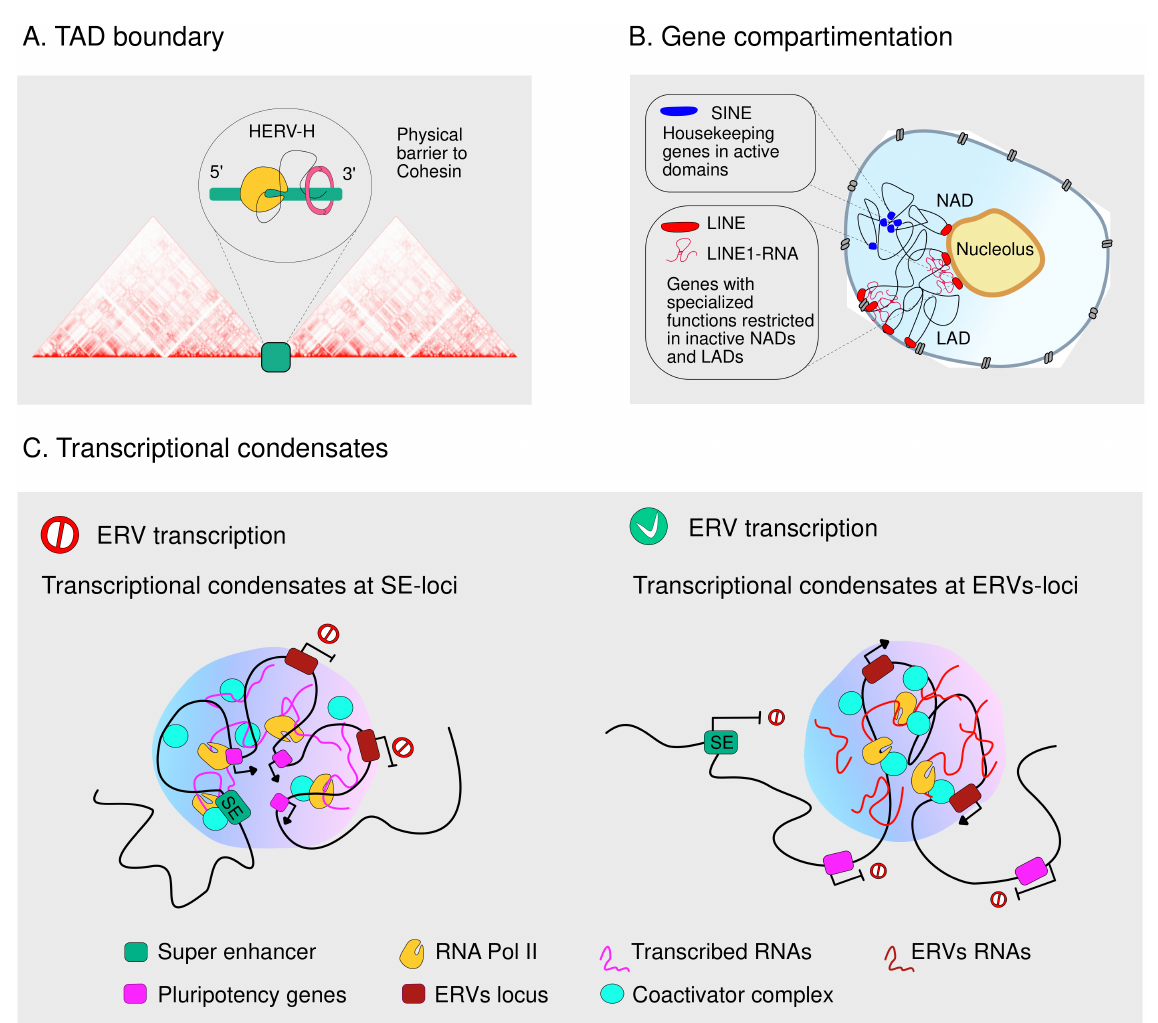
Figure 4. TEs organize the genome in the 3D space. Schematic representation of ( A ) HERV-H transcripts accumulation acting as physical barriers to the cohesin complex’s movement leading to the formation of a TAD boundary; ( B ) TEs guiding gene positioning in respect of their nature; ( C ) TEs RNAs transcriptional condensates: (left) in the absence of ERV active transcription, Pol II and coactivators are recruited at SE loci while, (right) whereby ERV are expressed, Pol II and coactivator complex are redirected into condensates at ERVs-loci affecting the transcriptional